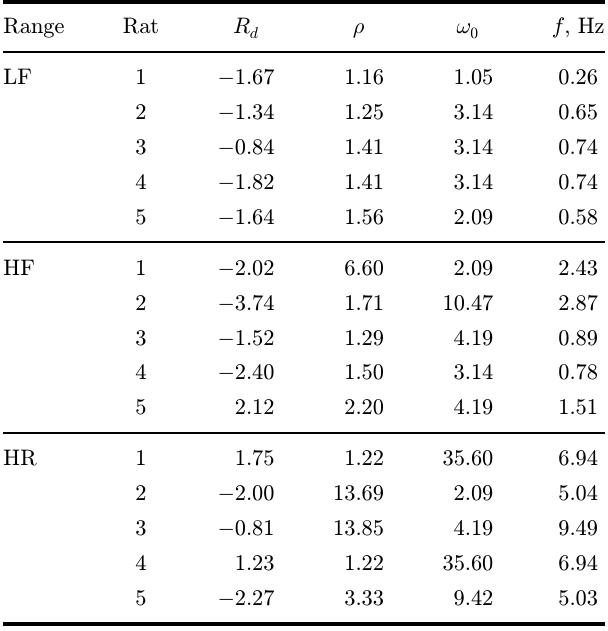
Table 1. Characteristics estimated within the analyzed OCT